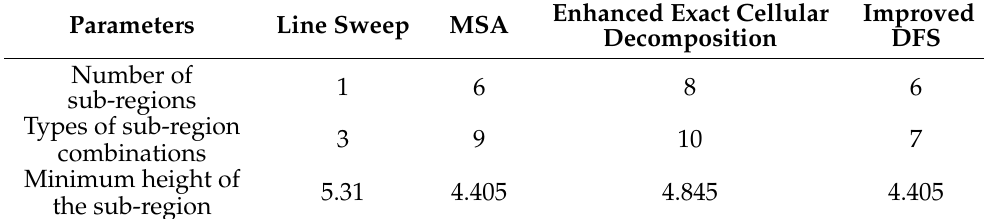
Table 4. Comparison of parameters between different